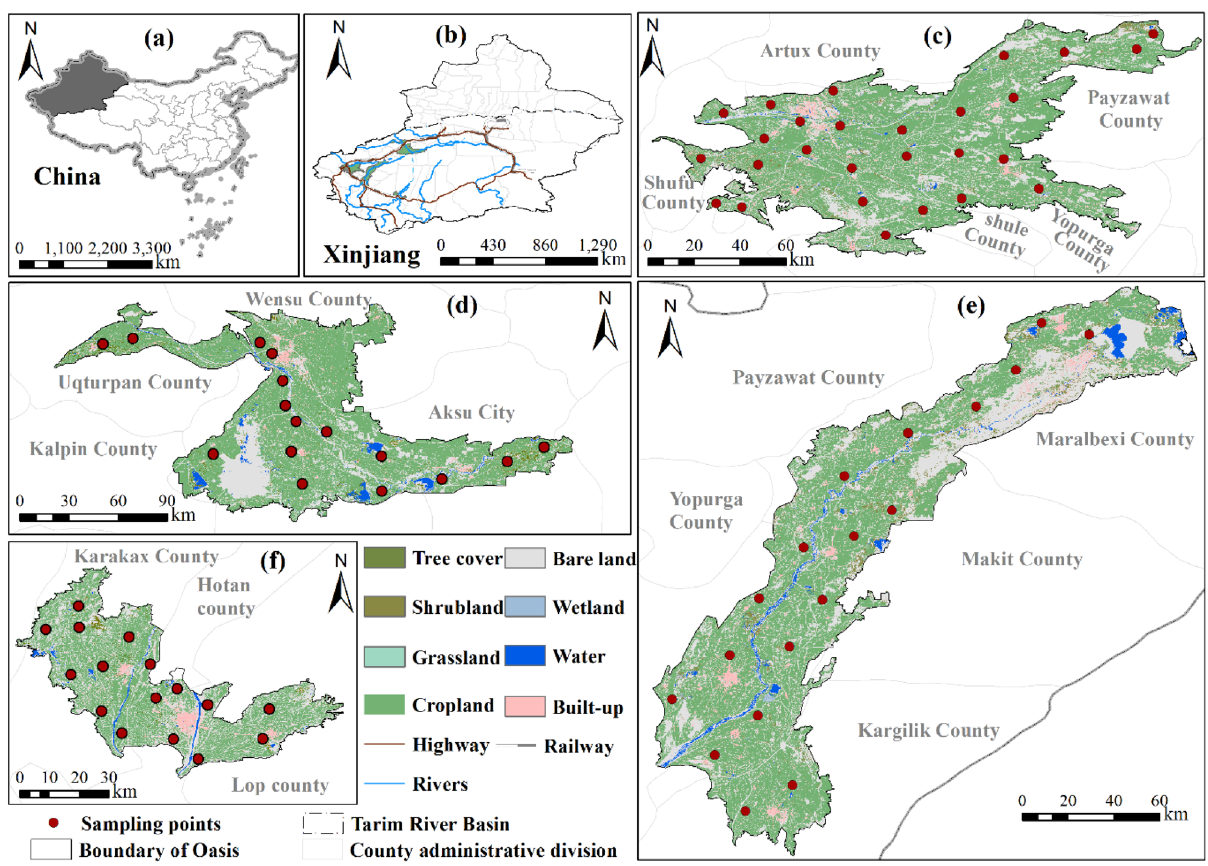
Figure 1. Sampling locations in the Kashgar Oasis ( c ), Aksu Oasis ( d ), Yarkant River Oasis ( e ) and Hotan Oasis ( f ). The graphs were generated by QGIS 3.26.3 (https:// www. qgis. org) and the review number of China Map is GS (2020) 4619, the Land use data are from the ESA global 30 m resolution land use cover dataset (https:// viewer. esa- world cover. org/ world cover). The combination of graphs ( a – e) was accomplished with linkscape 1.2.1 (https:// inksc ape.